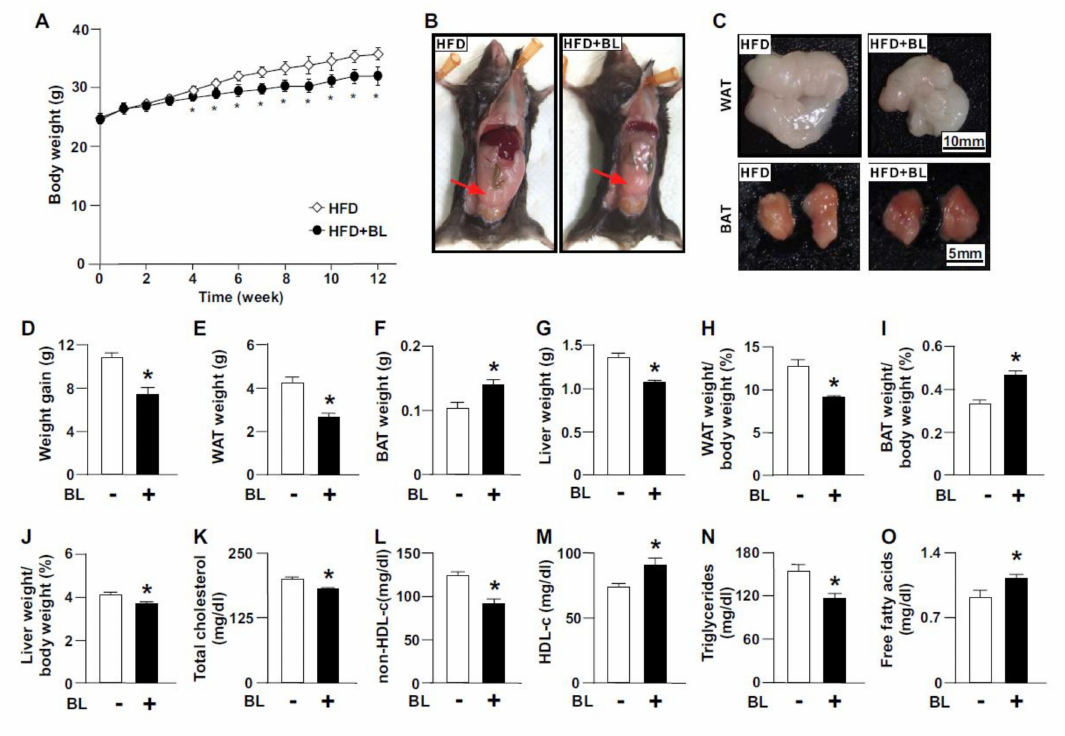
Figure 1. Effects of bromelain on body weight, tissue weight, and blood lipids of high-fat diet (HFD)-fed mice. With the HFD, eight-week-old C57BL / 6 mice were treated daily with bromelain (20 mg / kg) or